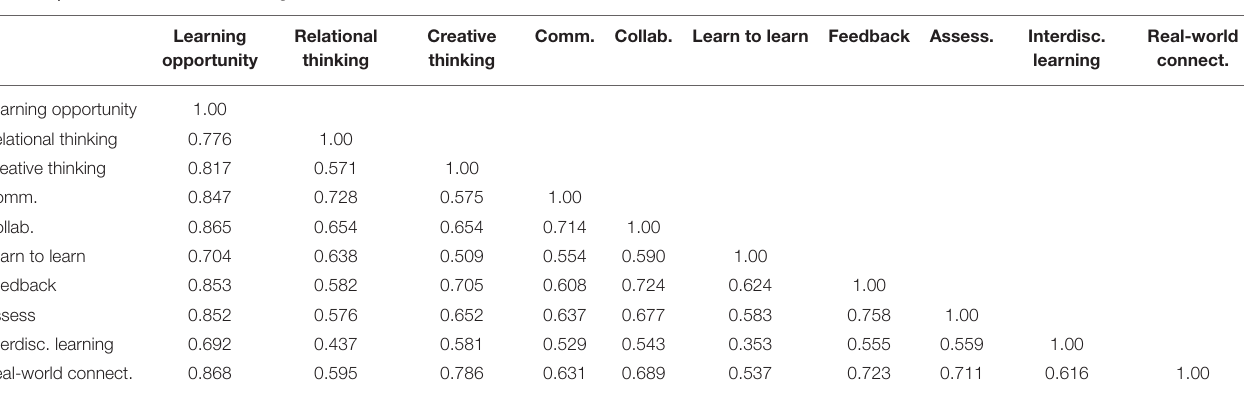
TABLE 3 | Observed correlations among administered